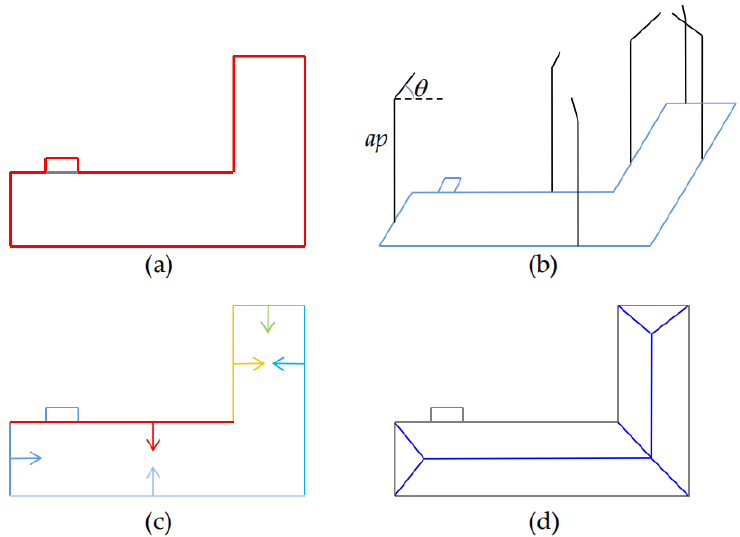
Figure 5. Illustration of the construction of the 2D topology. (a) the edges in a building; (b) the profiles corresponding to the edges; (c) the shifting of edges; (d) the 2D topology of the